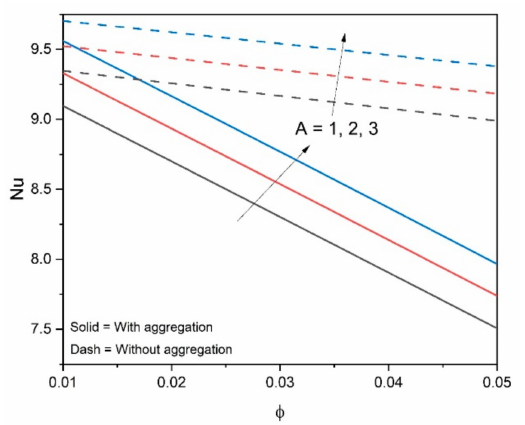
Figure 11. Influence of Nu on φ for numerous values of A .